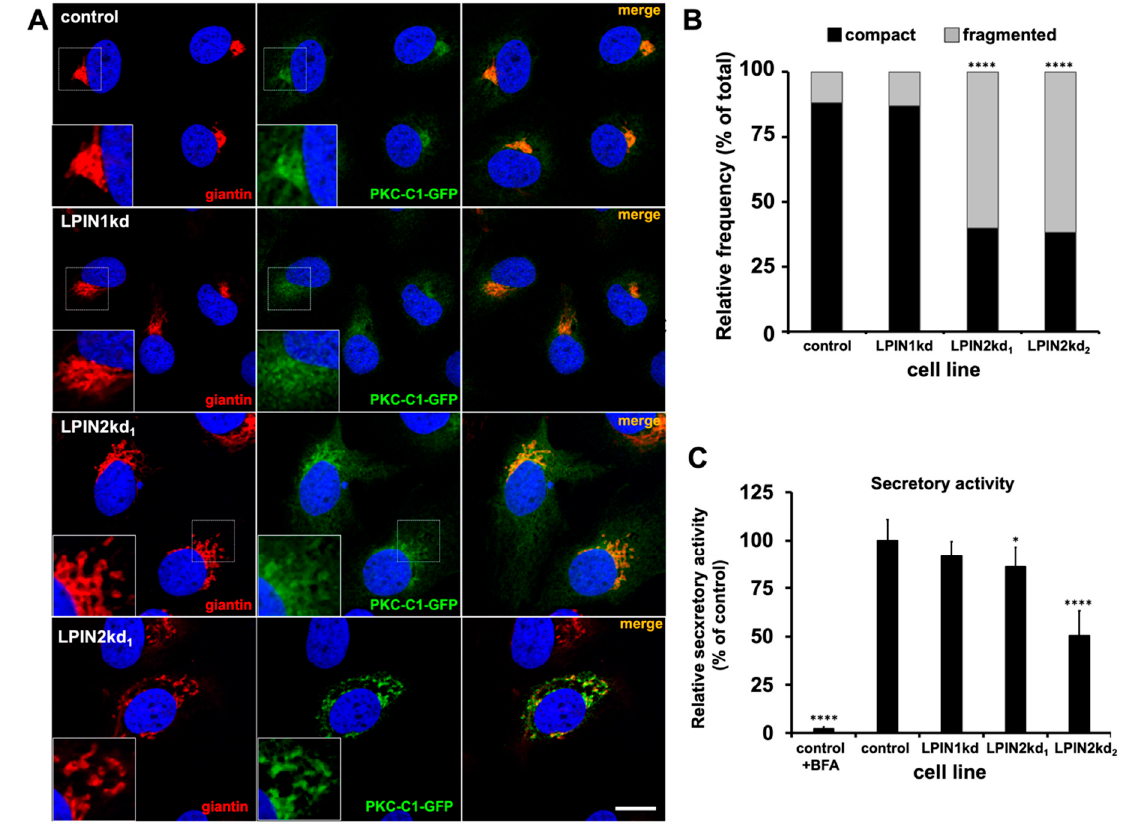
Figure 5. Lipin2, but not lipin1, silencing causes morphological alterations of the Golgi apparatus. Huh-7 cells constitutively expressing a DAG sensing probe (PKC-C1-D1-GFP) (see Materials and methods) were transduced with lentiviral vectors expressing non-targeting (control), shRNAs targeting LPIN1 (LPIN1kd) or LPIN2 mRNA (LPIN2kd 1 and LPIN2kd 2 ). At day 7 post transduction, control and lipin-deficient cultures expressing the DAG probe were fixed and processed for immunofluorescence microscopy using antibodies against a Golgi Apparatus marker (giantin) ( A ) Representative images of the Golgi morphology (red) and DAG probe (green) PKC-C1-GFP di ff erent cell lines. Nuclei were stained with DAPI and are shown in blue. ( B ) Relative frequency of the di ff erent Golgi morphologies. Data from four independent experiments are shown as percentage of the number of cells displaying compact or fragmented Golgi per total number of cells. Statistical significance was evaluated using Chi-square test and Bonferroni correction (n control = 868, n LPIN1kd = 578, n LPIN2kd1 = 633, n LPIN2kd2 = 568; * p < 0.0083; **** p < 0.0001). ( C ) Relative secretory capacity of lipin-deficient cells as determined by overexpression and secretion of Gaussia luciferase. Control cells were treated with secretion inhibitor brefeldin A (1 µ g / mL; control + BFA). Data are shown as average and SD of eight biological replicates from two independent experiments ( n = 8). Statistical significance was evaluated using one-way ANOVA and Dunnet´s post hoc test. (* p < 0.05; **** p <